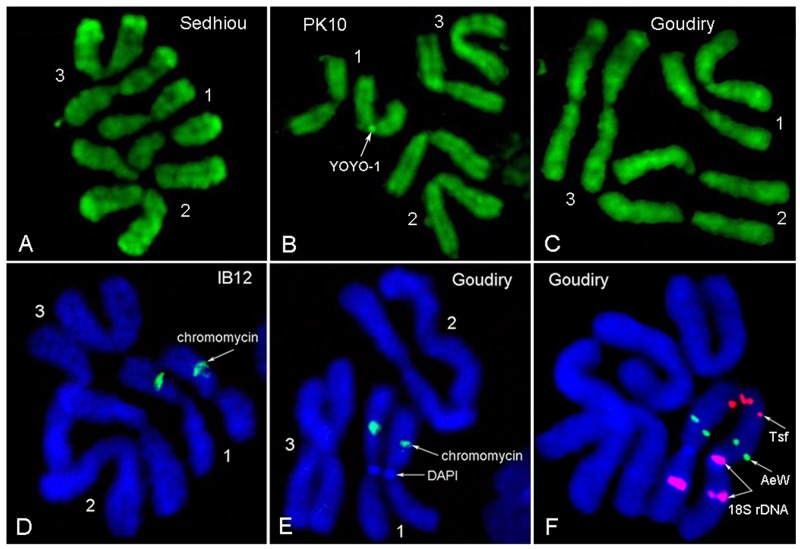
The differences in chromosome banding patterns in IB12 and 3 African strains of Aaf. YOYO-1 staining (A-C) revealed presence of a dark polymorphic band in chromosome 1 in the PK10 strain (B). Ribosomal locus in all strains was stained by chromomycin (D,E). Additional DAPI staining band was found in centromere of chromosome 1 in the Goudiry strain. FISH with BAC clones containing the transferrin (tsf) gene (red), white eye (AeW) (green) and rDNA (purple) genes demonstrated the presence of an additional ribosomal locus in this band (F). Note that two regions of rDNA staining exist on one of the chromosome 1 copies while a single region stains in the Aaa strain IB12 [48].